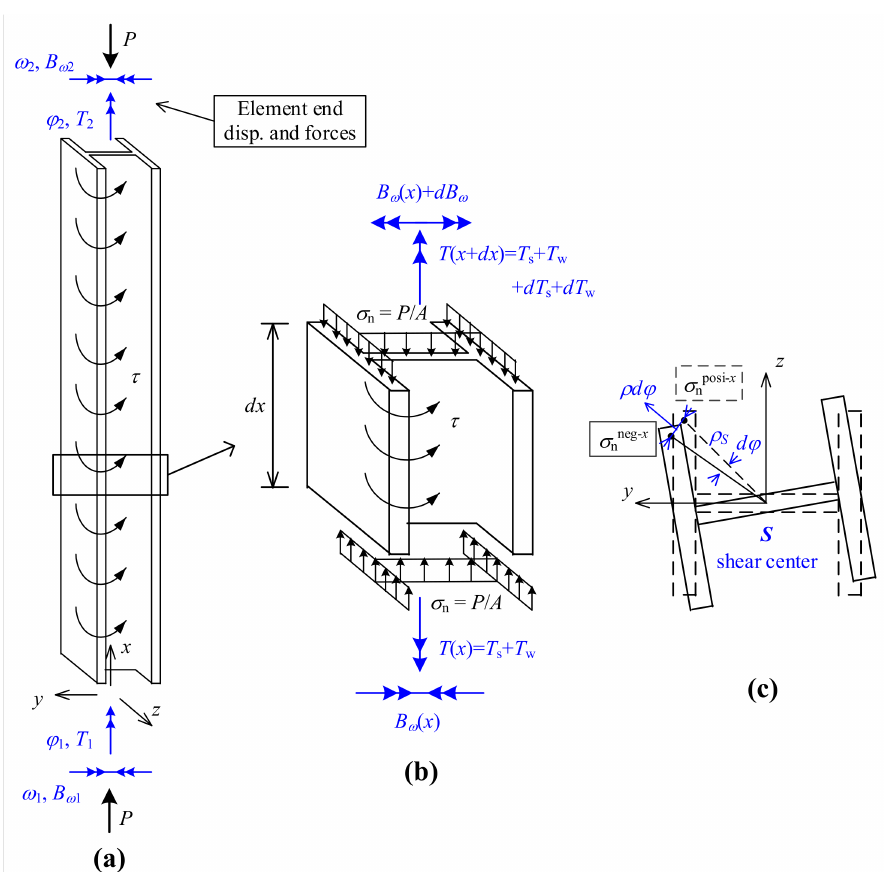
Figure 3. Equilibrium analysis of axial-loaded torsion member: ( a ) analyzed element with element- end torsion/warping deformations and stress resultants; ( b ) equilibrium analysis of element short segment side view; ( c ) cross-section elevation